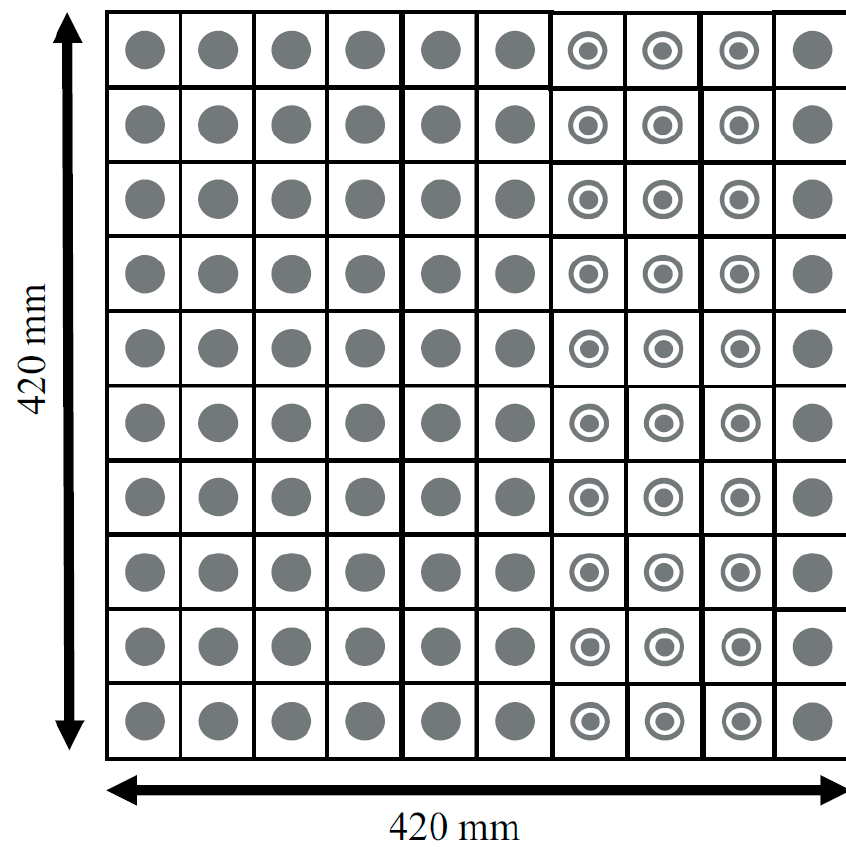
Figure 2. Top view and side view of the circular patch with a ring-type unit cell.